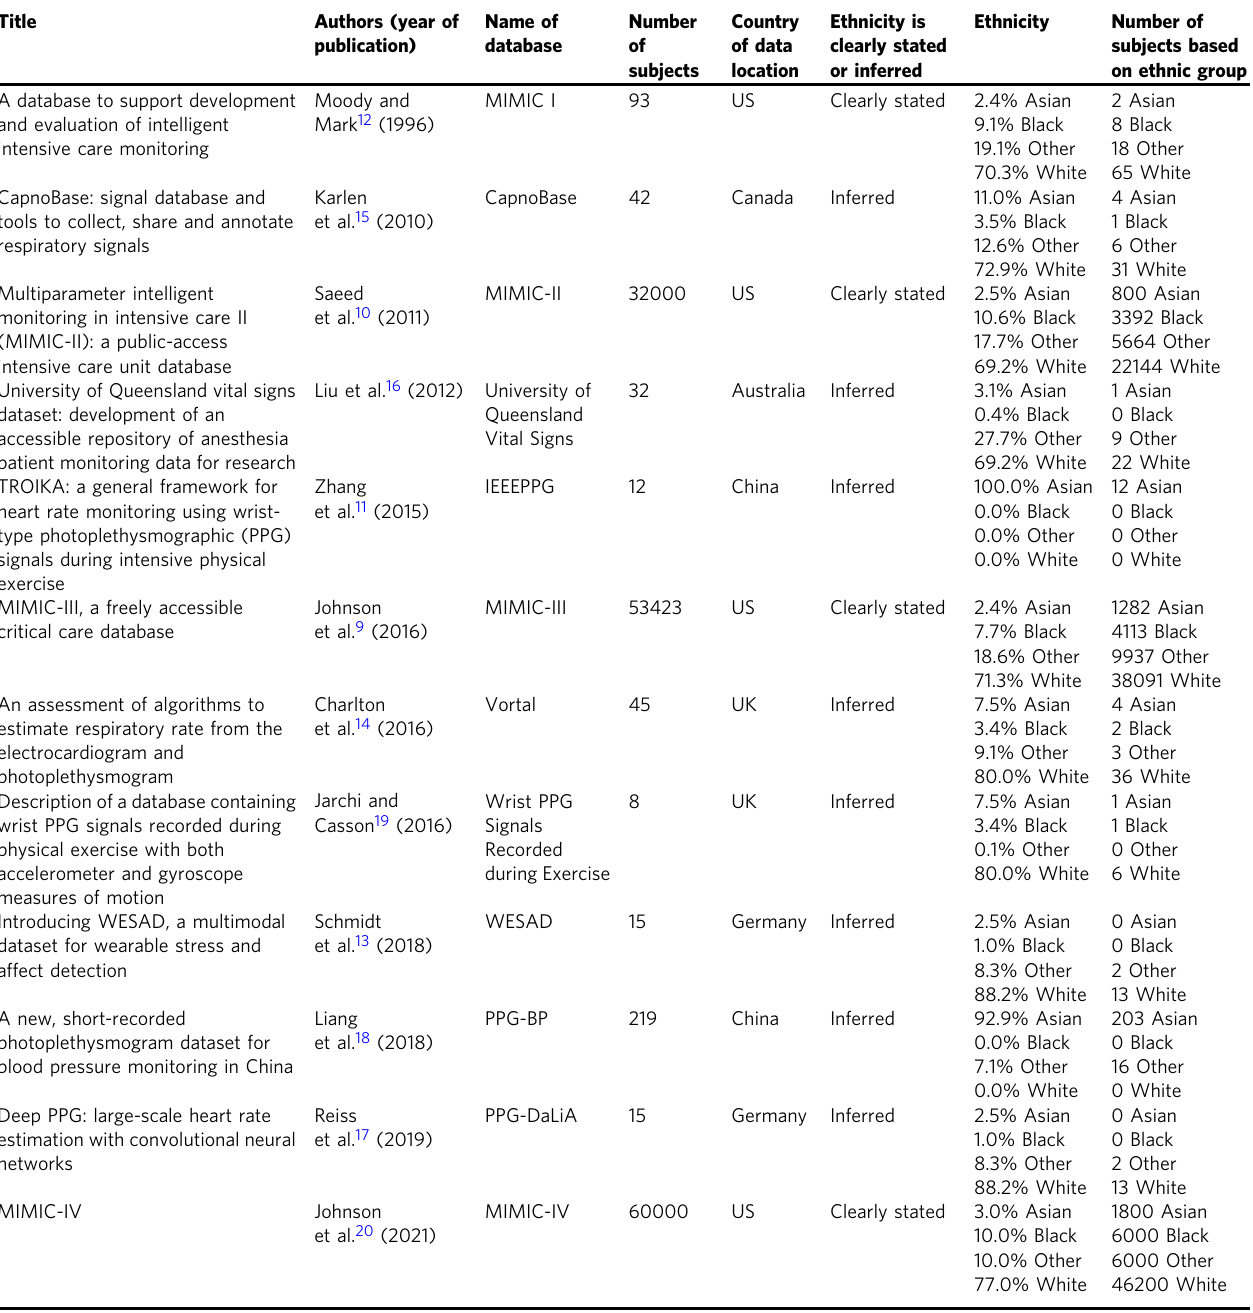
Table 1 Summary of all the 12 publicly available